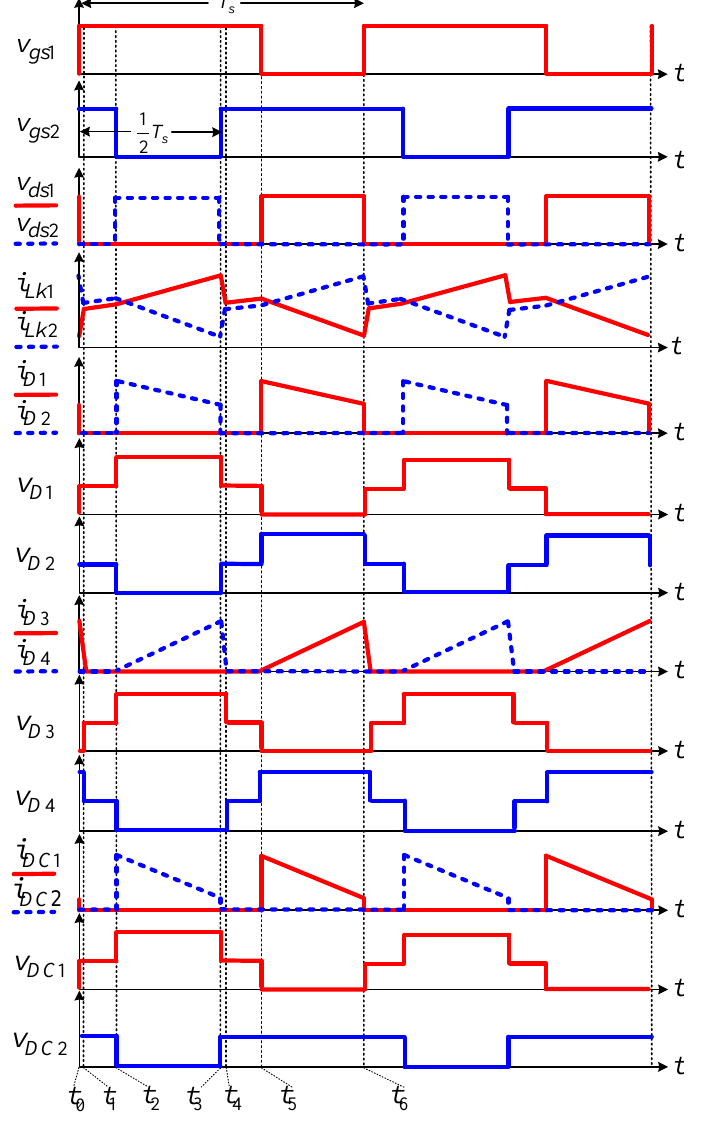
Figure 3. Key waveforms of the proposed converter.